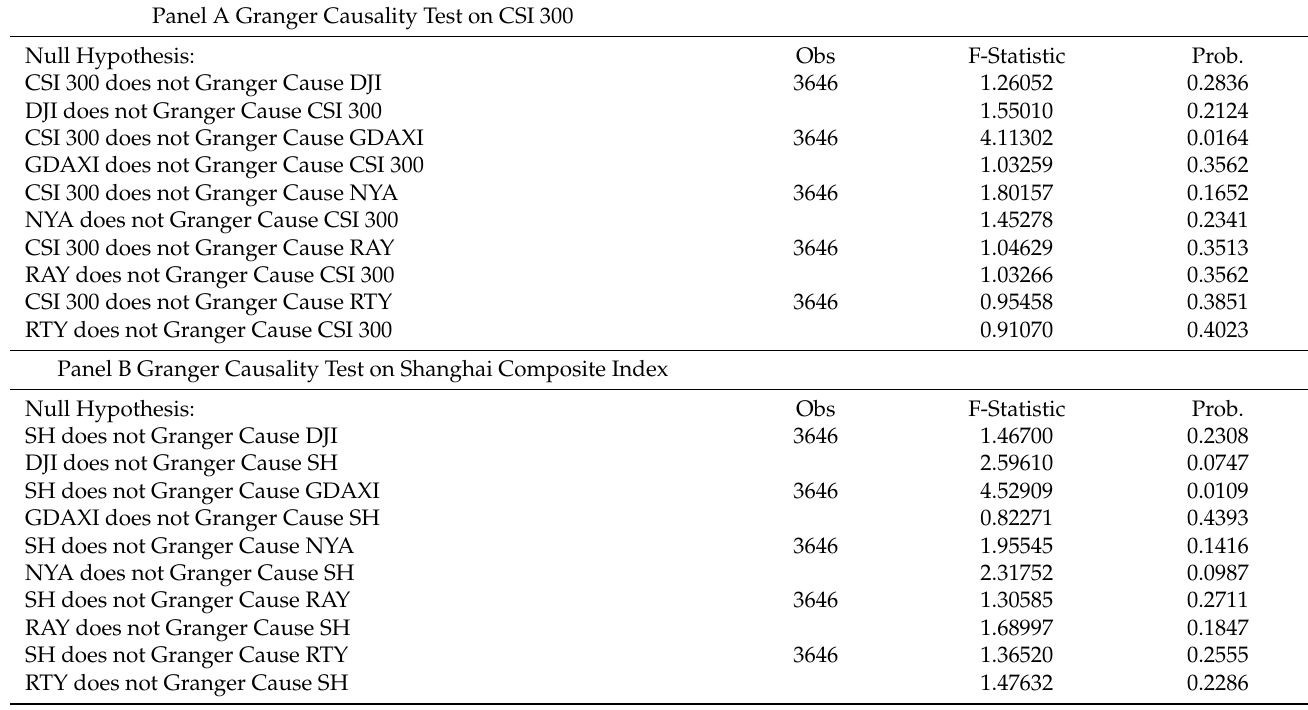
Table A3. Granger causality